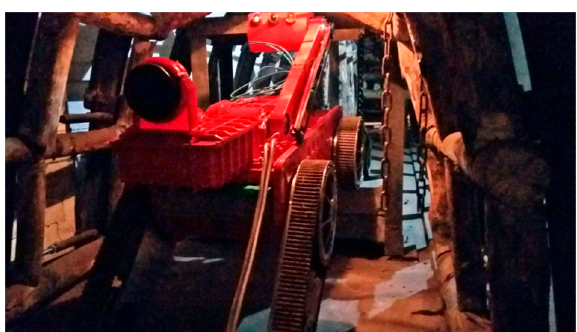
Figure 15. TeleRescuer—testing in a training coal mine Queen Luiza (March 2018).